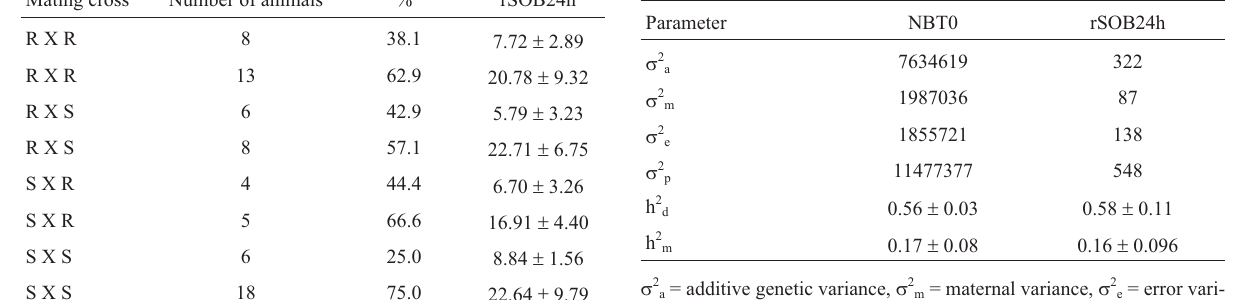
Table 4 - Genetic parameters for the number of bacteria at time 0 (NBT0) and for intracellular growth in vitro after 24 h (rSOB24h) in the Blanco Orejinegro Creole